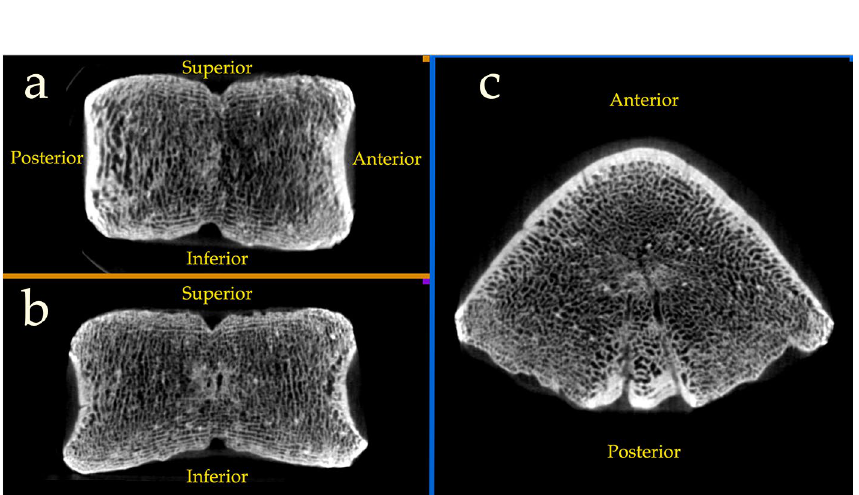
Figure 3. µCT scan of UB 10749. ( a ) Midsagittal section. ( b ) Coronal section. ( c ) Horizontal